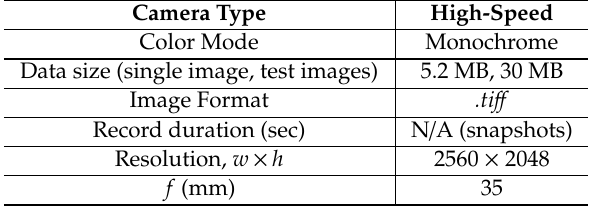
Figure 4. Test setup for validation of the proposed image compression method using a standard 1-in (25.4-mm) block inserted into a sliding verification bar. Table 1. Vision-based system configuration used for one-inch block verification tests.